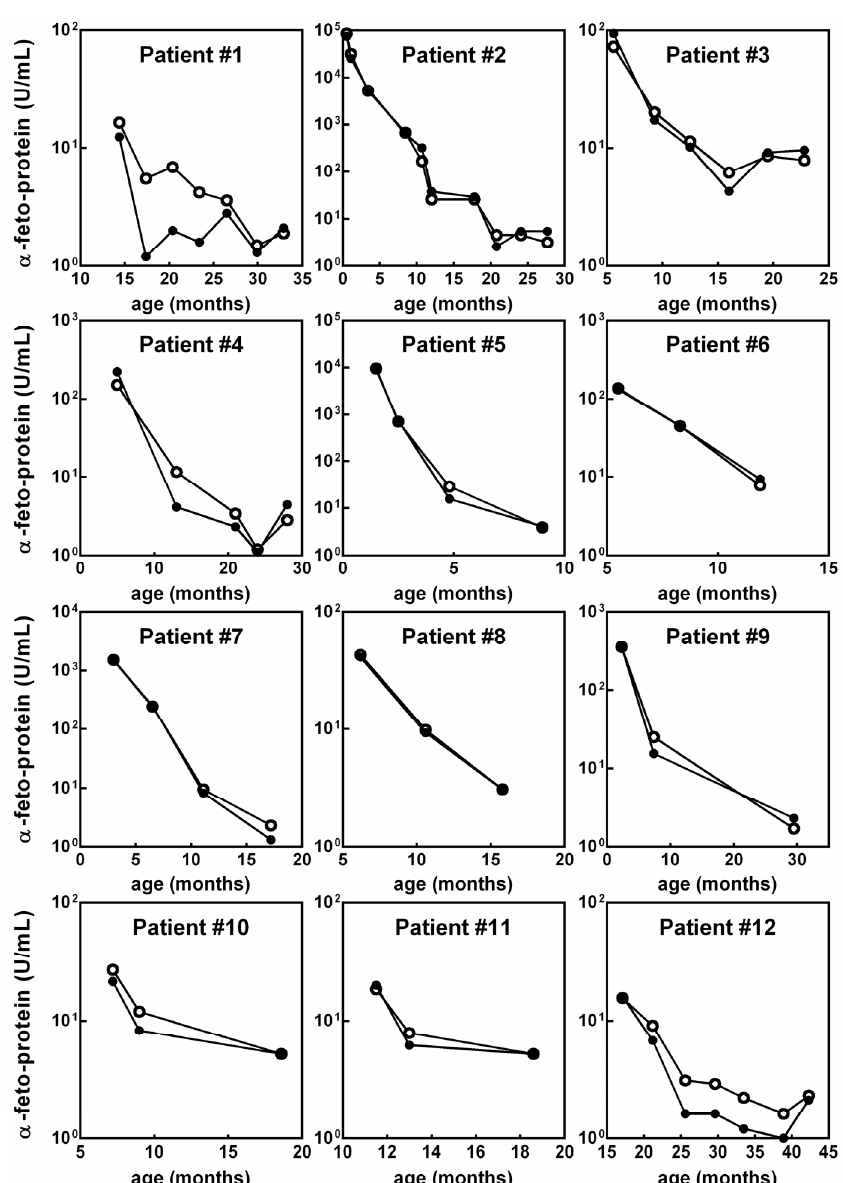
Figure 2. The longitudinal evaluation of alpha-fetoprotein ( α FP) plasmatic concentration on dried blood spots (DBS, closed circles) overlapped that on standard laboratory method (open circles) in the 12 patients affected by cancer-predisposition syndromes with α FP concentrations >10 U/mL.